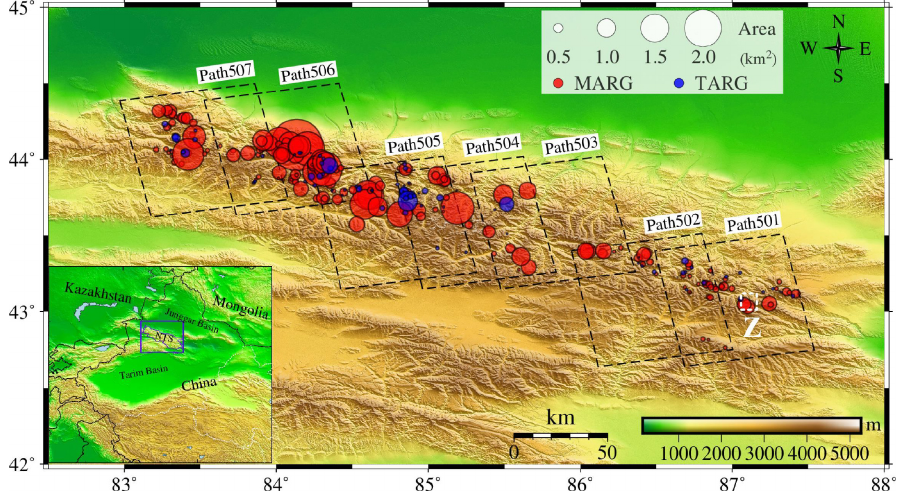
Figure 1. Topography map of the northern Tien Shan (NTS) of China. The black dashed boxes outline the footprints of seven PALSAR frames along paths 501–507. The red and blue circles represent moraine-derived active rock glaciers (MARGs) and talus-derived active rock glaciers (TARGs), respectively. The circle size represents rock glacier area. The white dashed box (labeled as “Z”) is shown in Fig. 3a and b. Table 1. List of interferograms made from the seven paths of ALOS PALSAR data. Interferogram names are the conjunction of acquisition dates of the two images. The last column gives the number of identified active rock glaciers (ARGs) in each interferogram. Path/frame Interferogram Time span Perpendicular Number of (days) baseline (m) identified ARGs 501/850 46 314